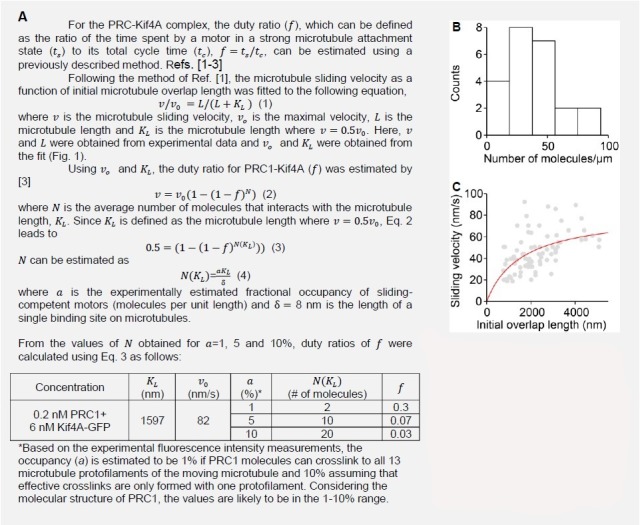
A) Calculation of the duty ratio of the PRC1-Kif4A molecules. B) Estimation of the number of molecules/µm from experimental fluorescence intensity measurements. C) The fitting of Eq. 1. (red line) to the microtubule sliding velocity as a function of initial microtubule overlap length data (Assay condition: 0.2 nMPRC1 + 6 nM Kif4A-GFP (gray circles; N = 84).